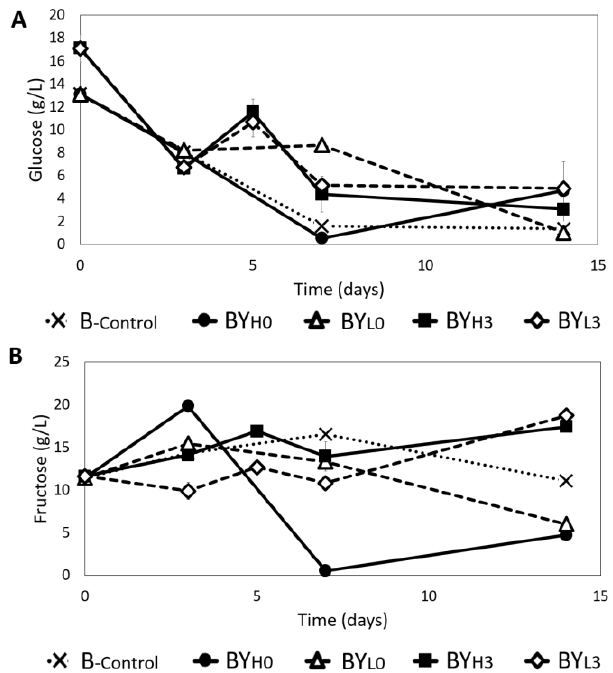
Figure 4. Changes in ( A ) glucose and ( B ) fructose concentration during 14 days of cultivation using K. intermedius mono-(B -control ) and co-cultures with D. bruxellensis at 30 ◦ C. D. bruxellensis was added simultaneously at concentrations of 10 6 CFU/mL (BY H0 ) and 10 3 CFU/mL (BY L0 ) and sequentially at 10 6 CFU/mL (BY H3 ) and 10 3 CFU/mL (BY L3 ).